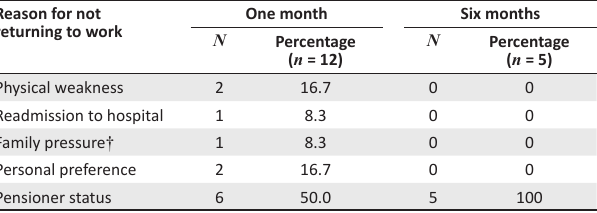
TABLE 6: Reasons for not returning to work at 1 and 6